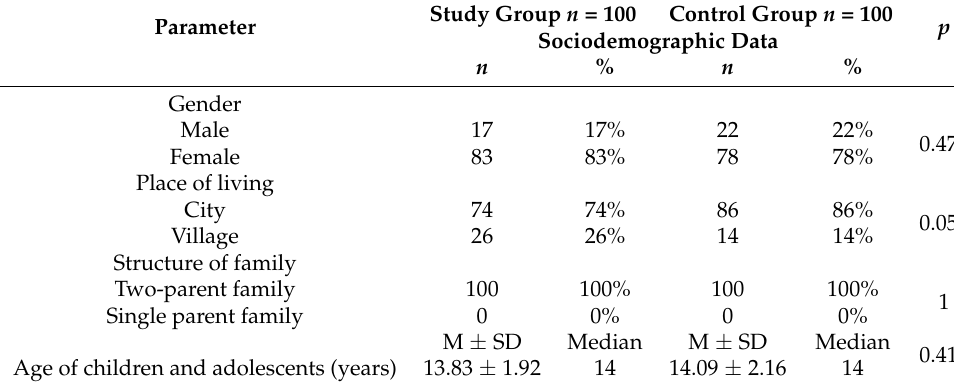
Table 1. Characteristics of the study